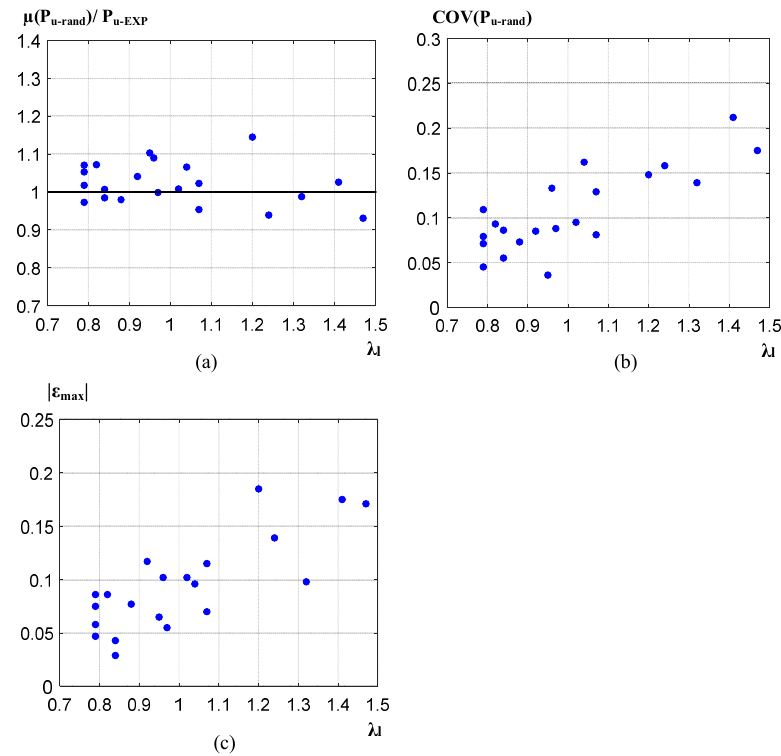
Figure 10. Predicted results against cross-sectional slenderness. ( a ) µ (P u-rand ) / P u-EXP versus λ l ; ( b ) coefficients of variation (COV) (P u-rand ) versus λ l ; ( c ) | ε max | versus λ l .